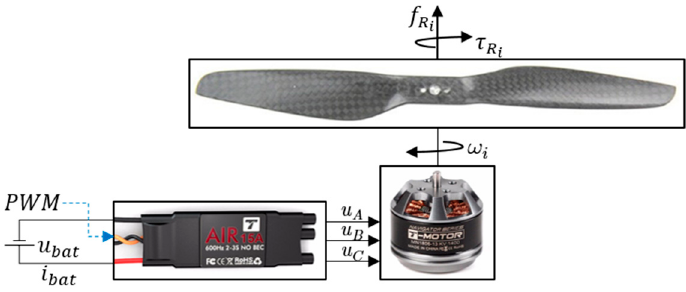
Figure 4. EPU components.